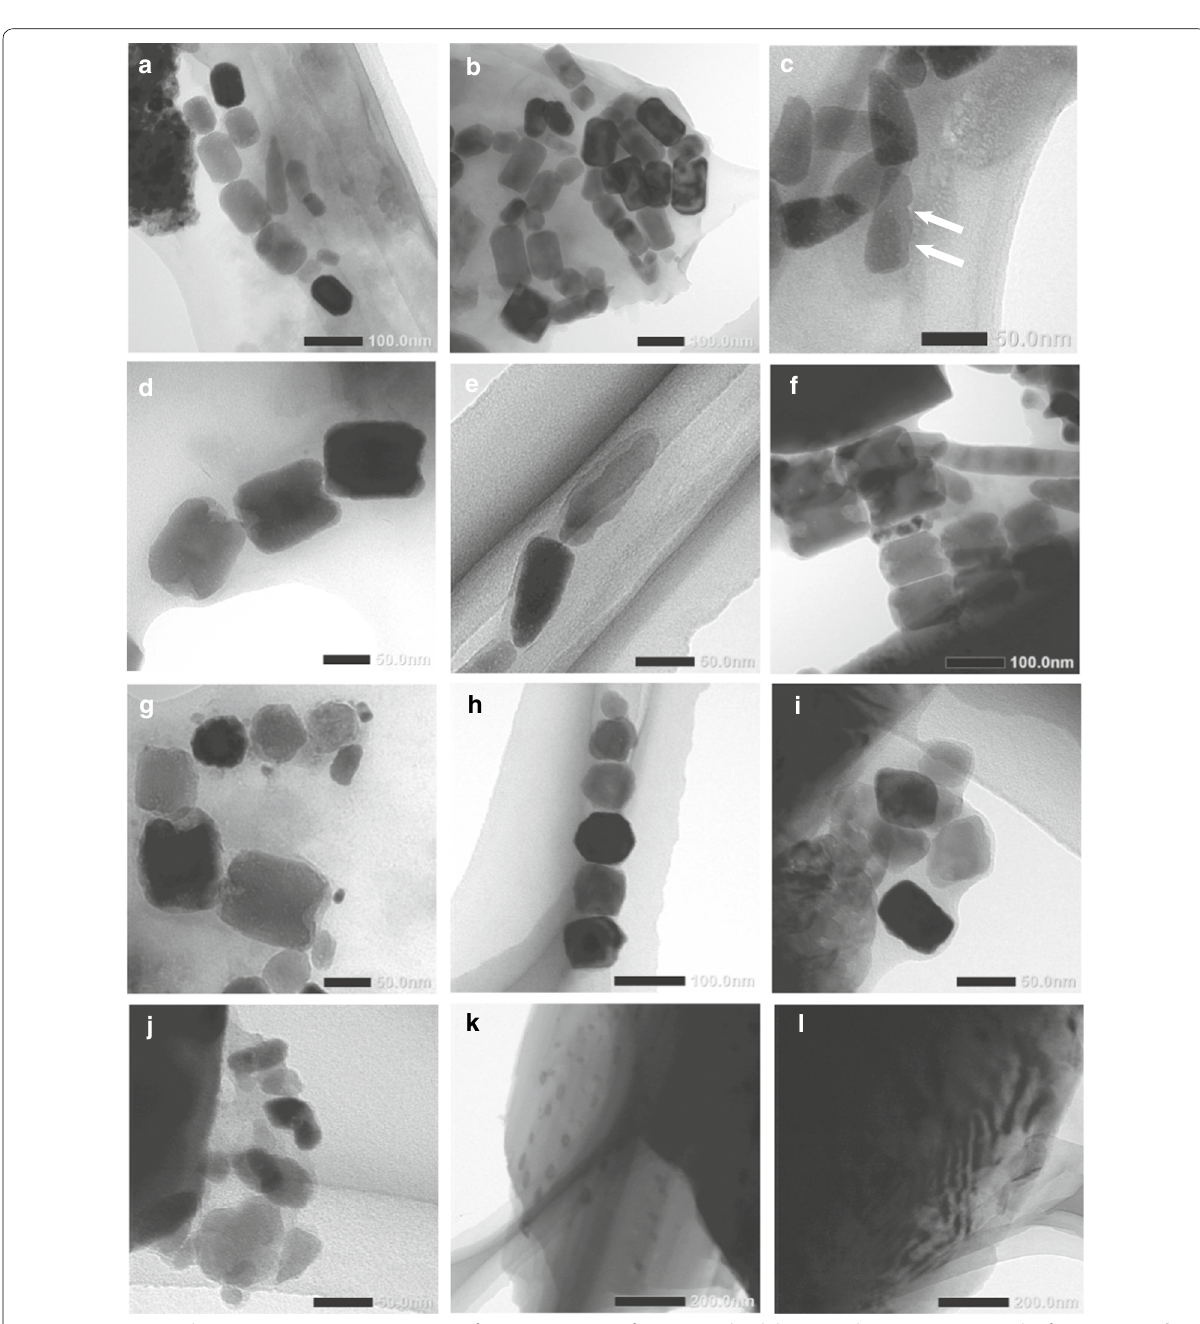
Fig. 4 Transmission electron microscope (TEM) images of magnetic extracts from seven depth horizons shown in Fig. 2. Samples from a 1.00 m, b , c 1.14 m, d – f 1.18 m, g , h 1.23 m, i , j 1.27 m, k 1.36 m, and l 1.49 m. Magnetofossils in ( a , b ) have sharp crystal edges, whereas those of ( c ) through ( j ) are partially etched. Grains in k , l are likely silicates with magnetic inclusions. Scale bar: 50 nm ( c – e , g , i , j ), 100 nm ( a , b , f , h ), and 200 nm ( k, l